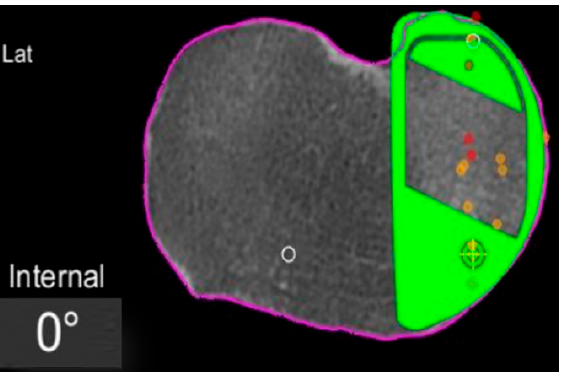
Figure 2. Tibial component rotation (tibial rotation angle, TRA) is set to 0° considering the femur- based rotation landmark. The green area represents the implant. The purple line represents the seg- mentation of the CT-scan. Red dots are the recorded contact points of the femur on the tibia, yellow dots the cartilage level that was recorded with a blunt probe during surgery, in order to fi ne-tune the resection level.